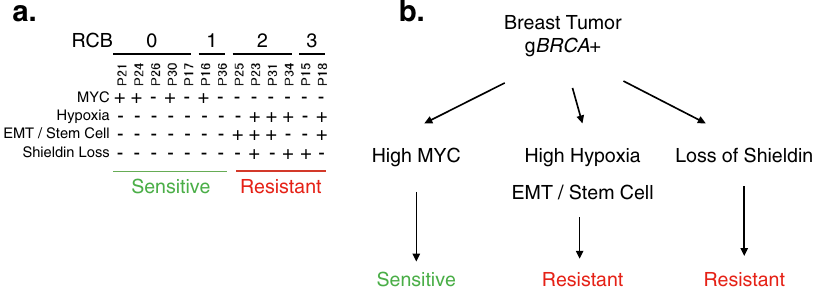
Fig. 5 Model. a This table shows each of the tumors in the trial, grouped by RCB status. The tumors predicted to have an activated Hypoxia pathway, based on the pathway signature and expression of HIF targets, are indicated in the fi rst row with a “ + ” . The EMT / Stem Cell status is determined from the expression of the leading edge EMT genes. Shieldin Loss re fl ects the concomitant loss of copy number and expression of SHLD2. b In this cohort of g BRCA mutant breast cancer patients, loss of shieldin, high hypoxia signature, or high EMT/Stem Cell signature is predictive of